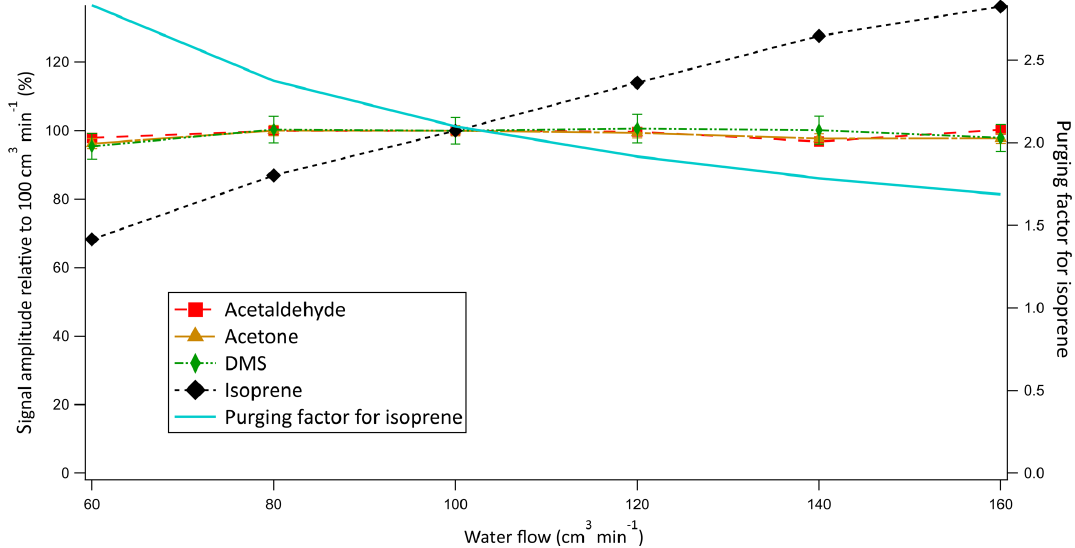
Figure 5. Relative signal as a function of water flow into the equilibrator. Error bars represent random error propagation with the initial error determined from the standard deviation of 10 consecutive 6min blank measurements.